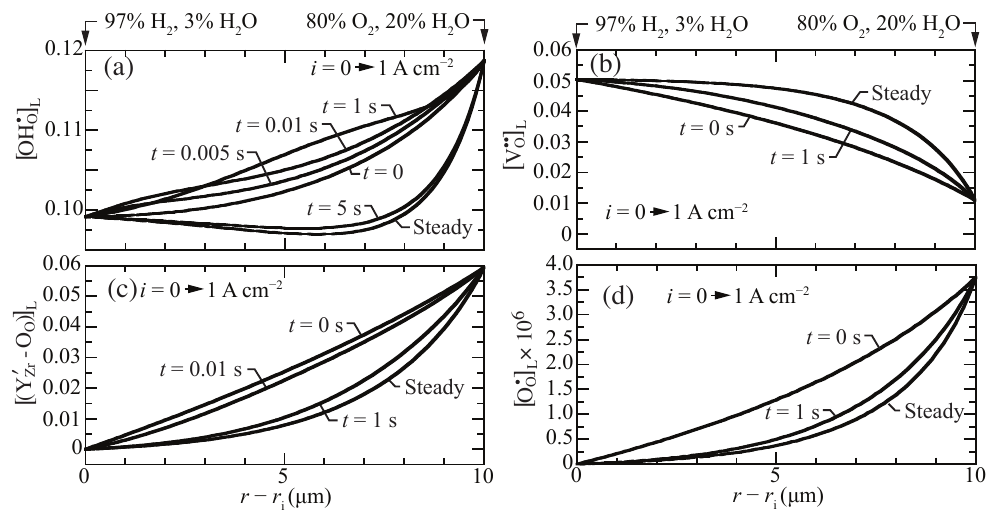
Figure 3. Charged-defect concentration profiles (lattice units) during a transient between open circuit and a suddenly imposed current density of i = 1 A cm − 2 . The cell temperatures is fixed at 600 ◦ C. ( a ) protons, ( b ) oxygen vacancies, ( c ) trapped polarons, and ( d ) O-site polarons.